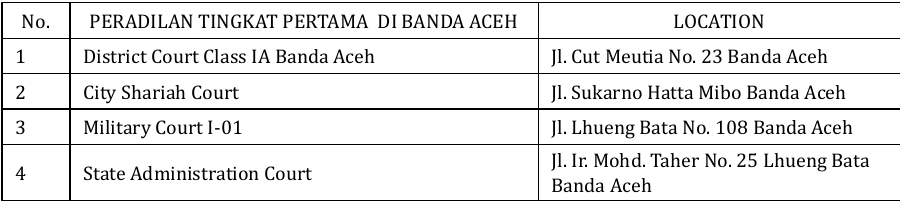
Table 1. Court Systems in